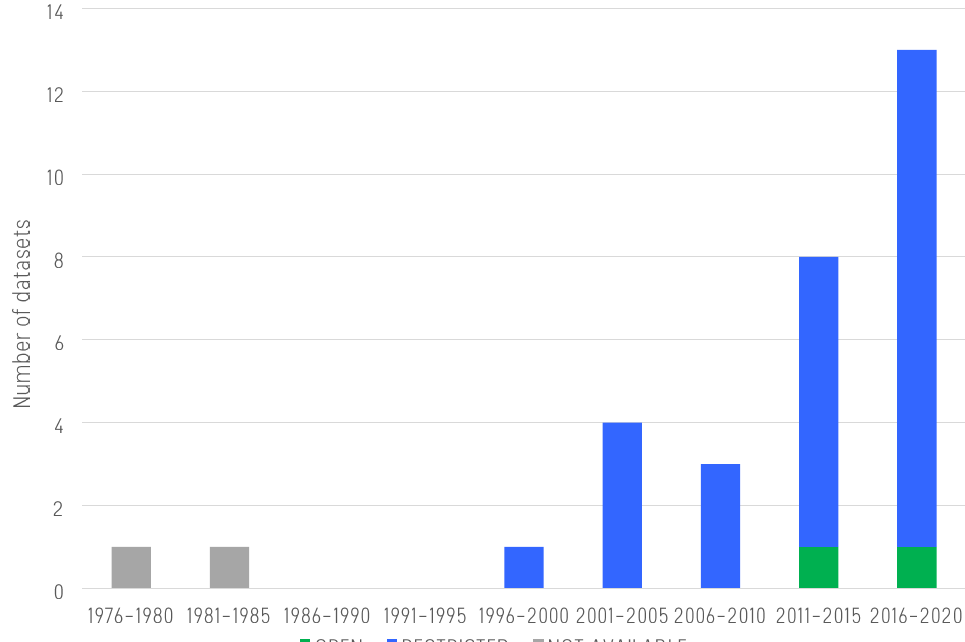
Figure 6. Household scale dataset count and accessibility over time.